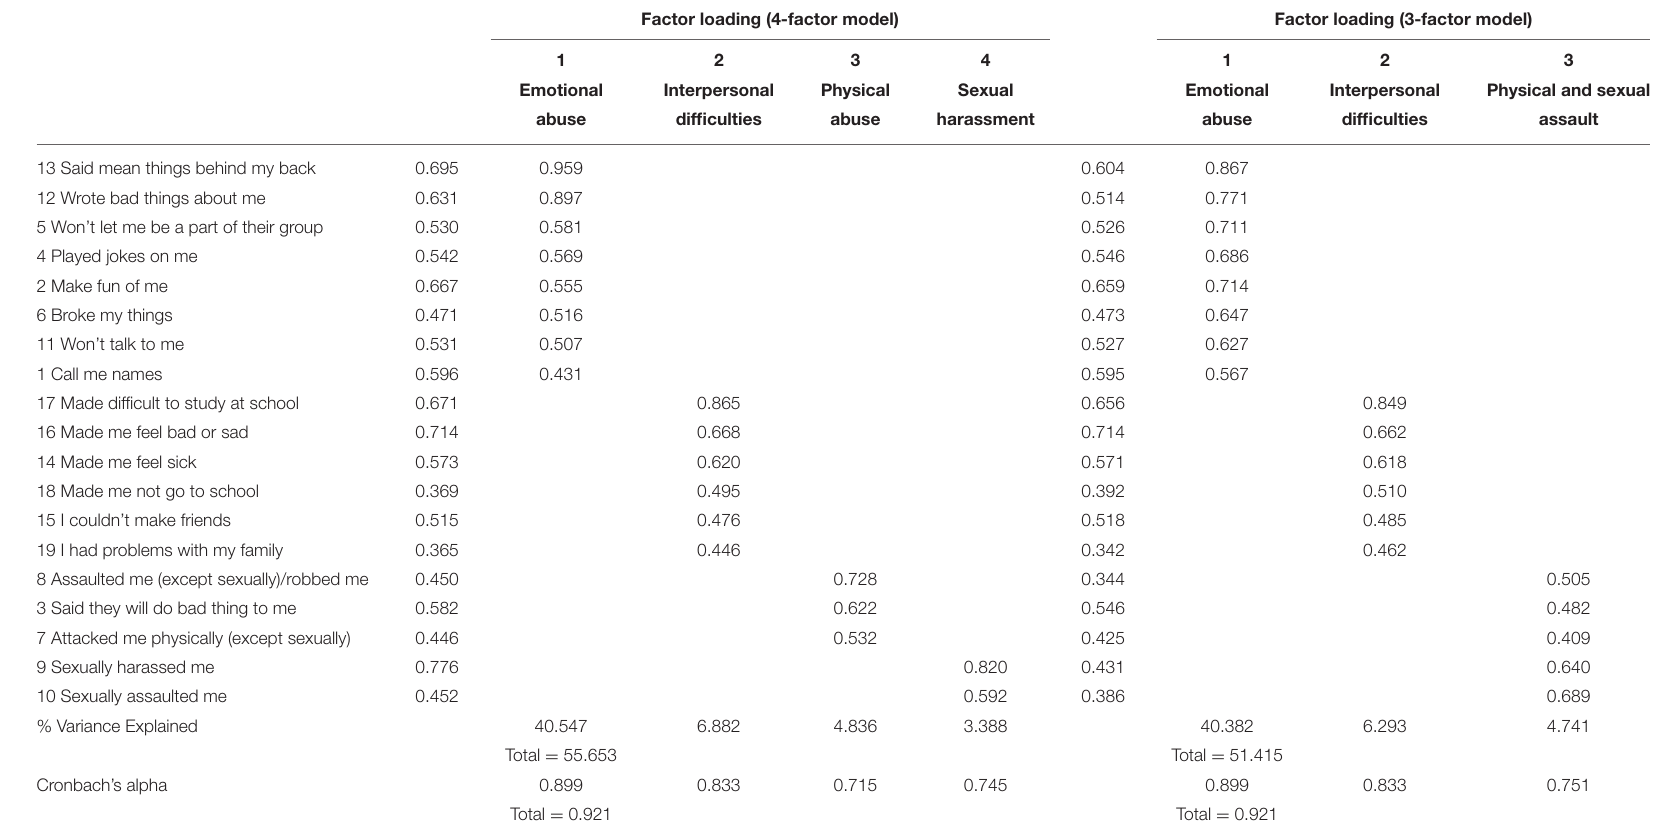
TABLE 2 | Factor loadings of the Chinese version of Bullying Scale for Adults (C-BSA) ( N =